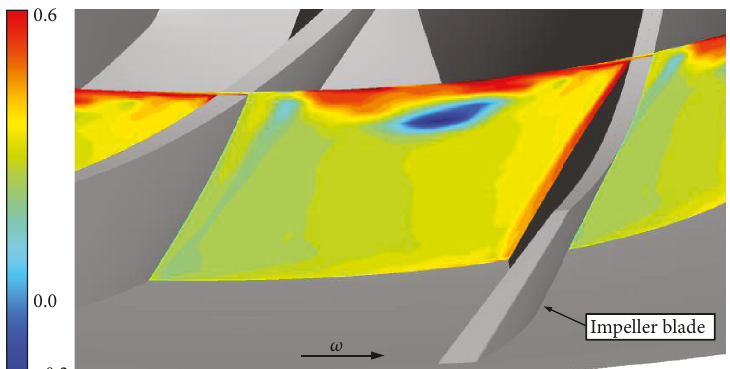
Figure 14: Entropy di ff erence due to unsteadiness in the impeller for the NC.